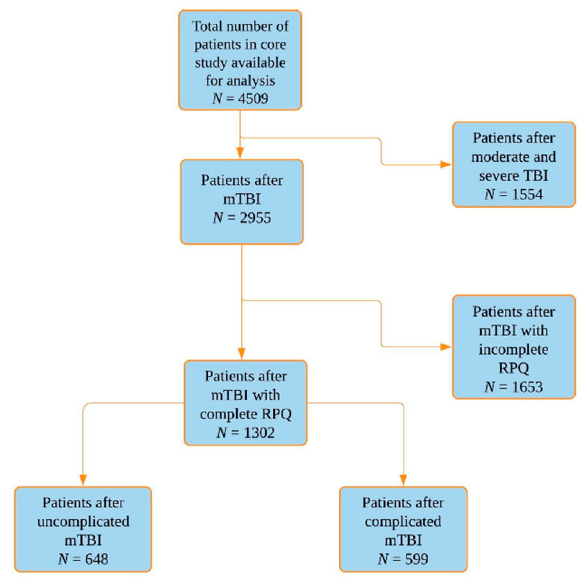
Figure 1. Flowchart sample size. N , number; mTBI, mild traumatic brain injury; RPO, Rivermead Post-Concussion Symptoms Questionnaire.